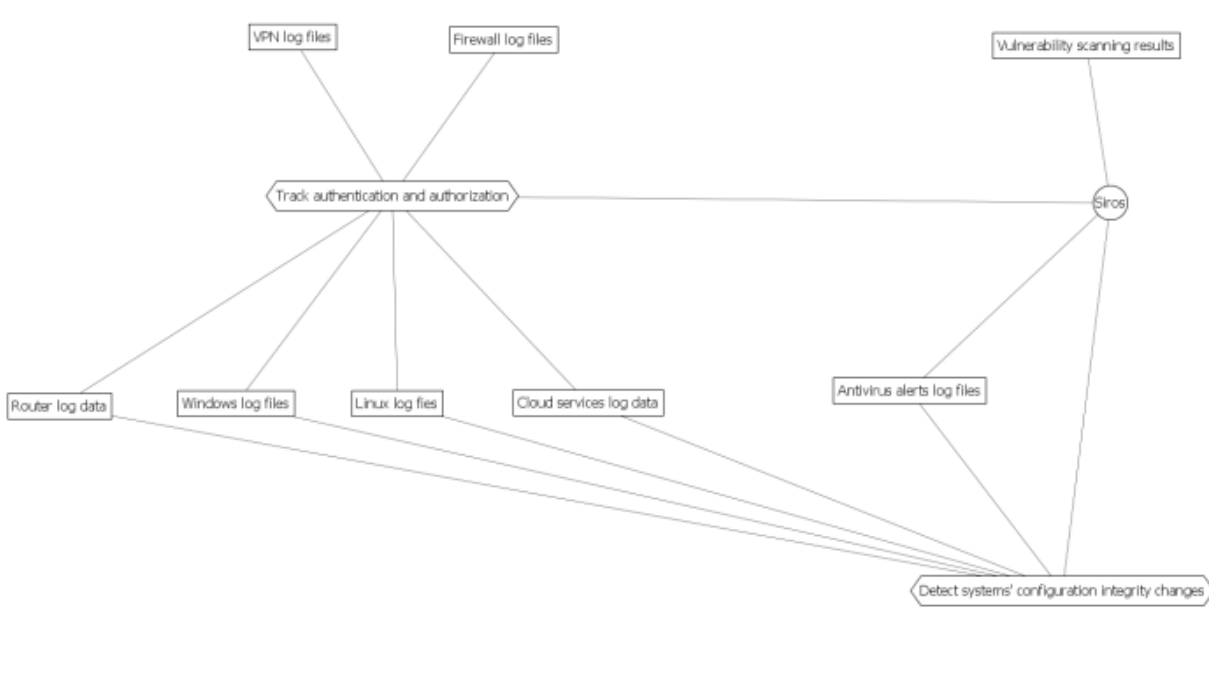
Figure 9. ‘Siros’ log collector